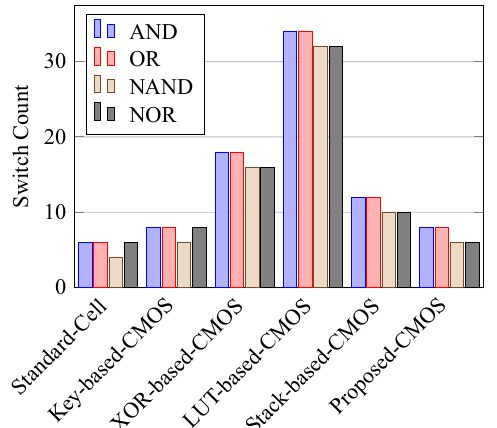
Figure 29. Switch count for gates.